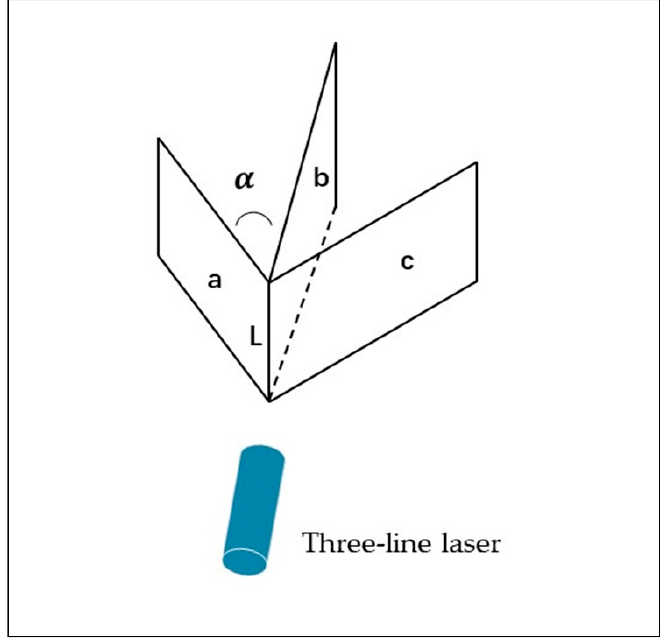
Figure 5. Spatial geometric relationship of the structured light planes.